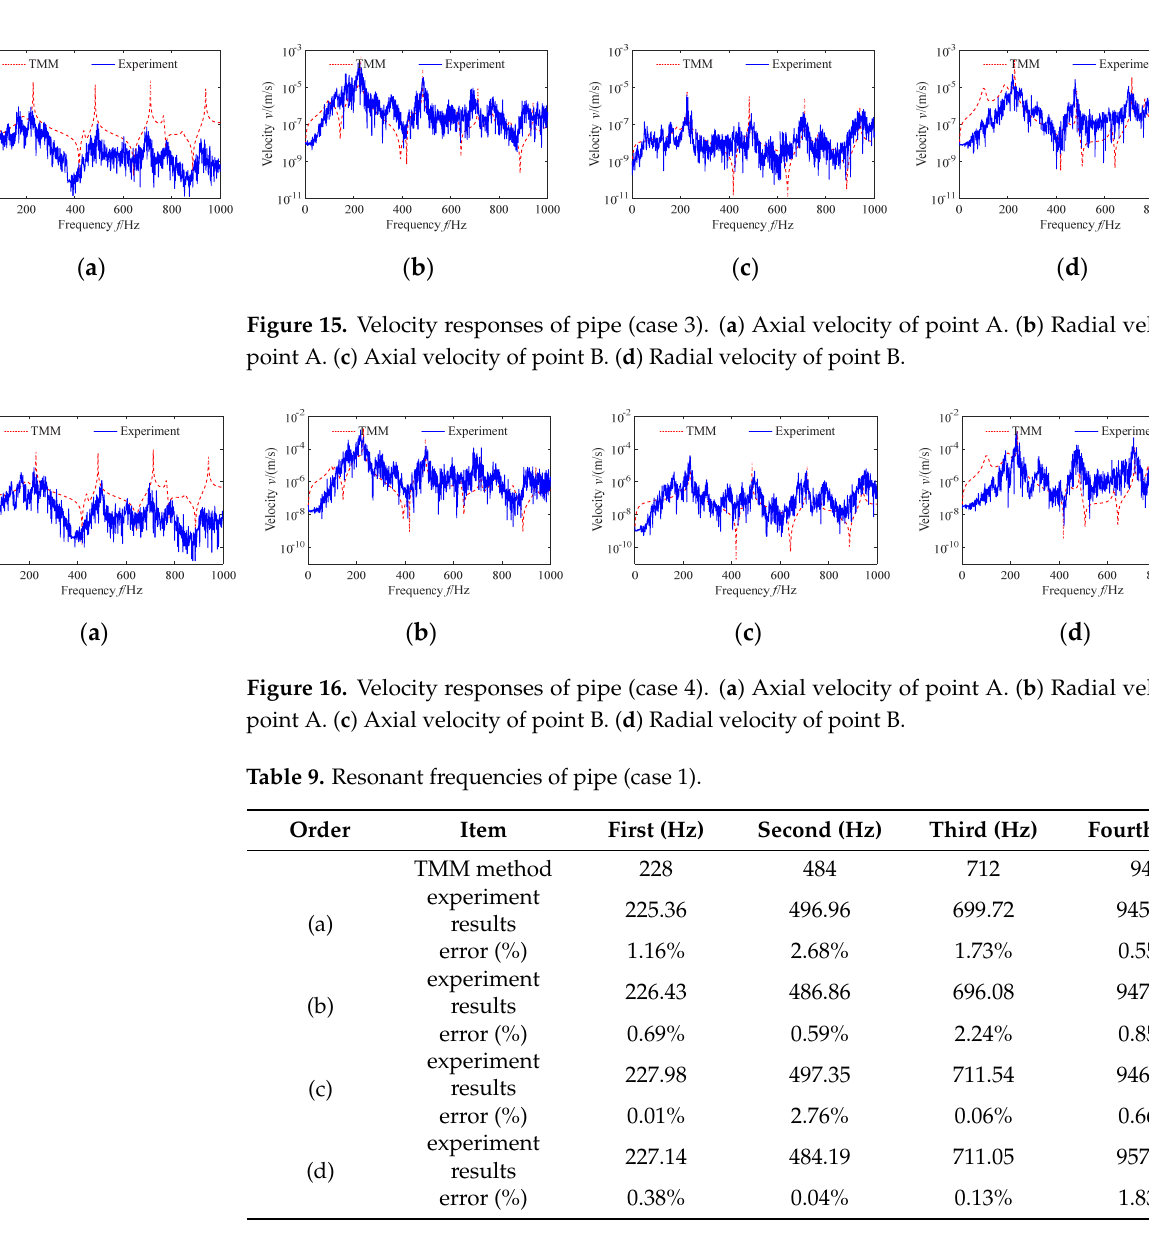
Figure 15. Velocity responses of pipe (case 3). ( a ) Axial velocity of point A. ( b ) Radial velocity of point A. ( c ) Axial velocity of point B. ( d ) Radial velocity of point B. Table 11. Resonant frequencies of pipe (case 3).